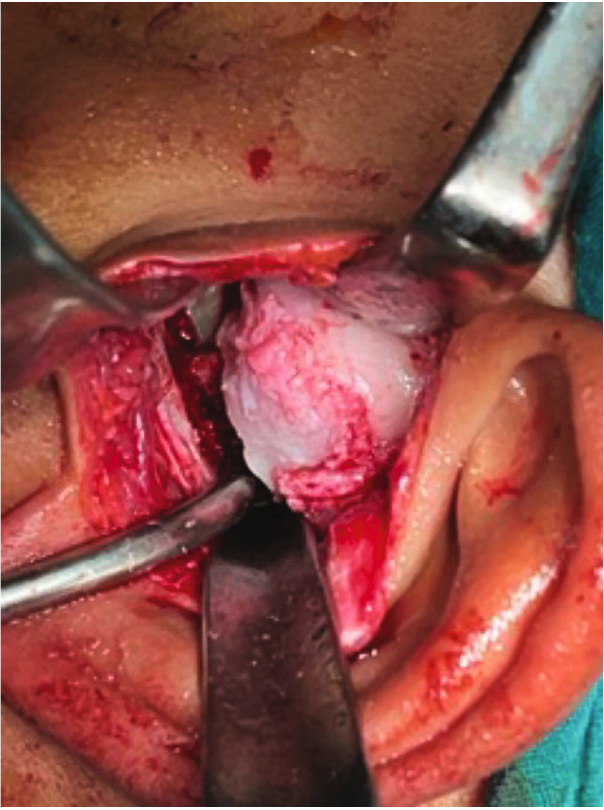
Figure 7: Osteotomy of the ankylotic